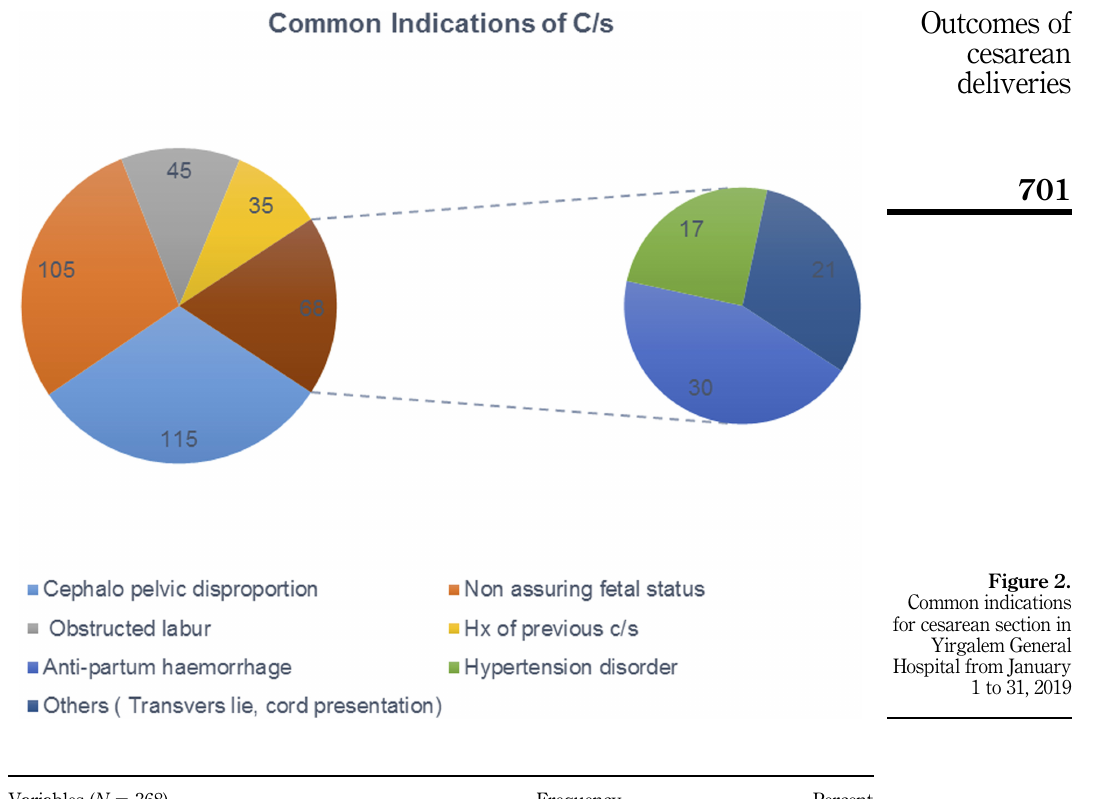
Table 2. History of